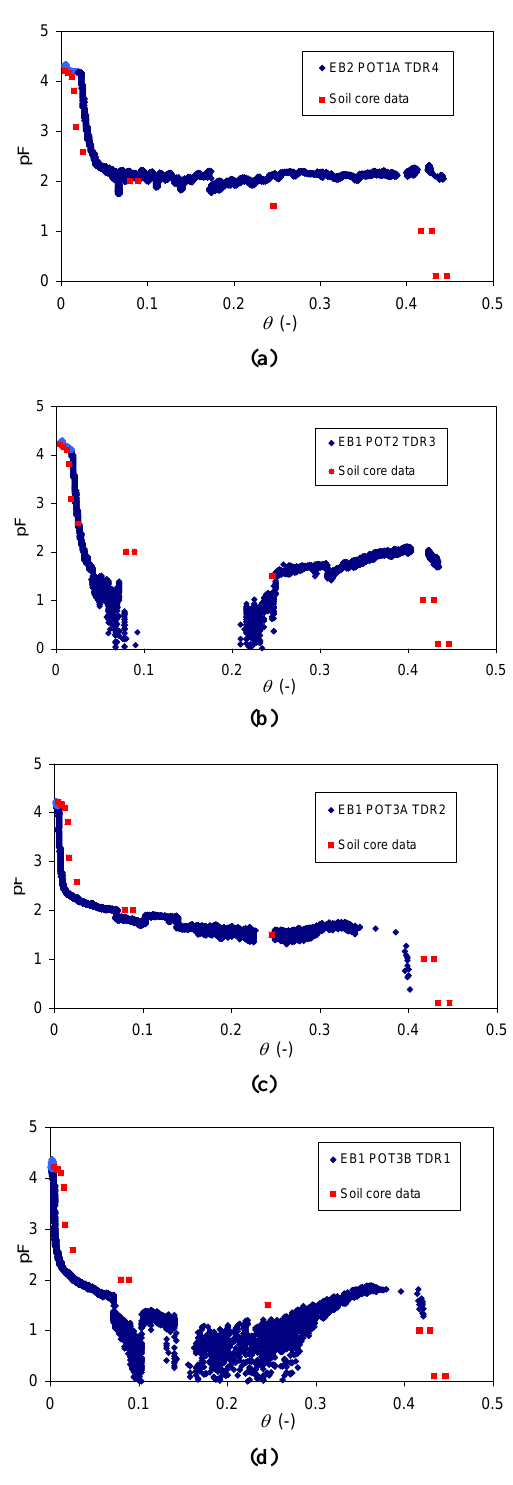
Fig. 10. pF curve of EB1 for the paired polymer tensiometers (POTs) and time domain reflectometers (TDR) together with gravi- metric data from soil